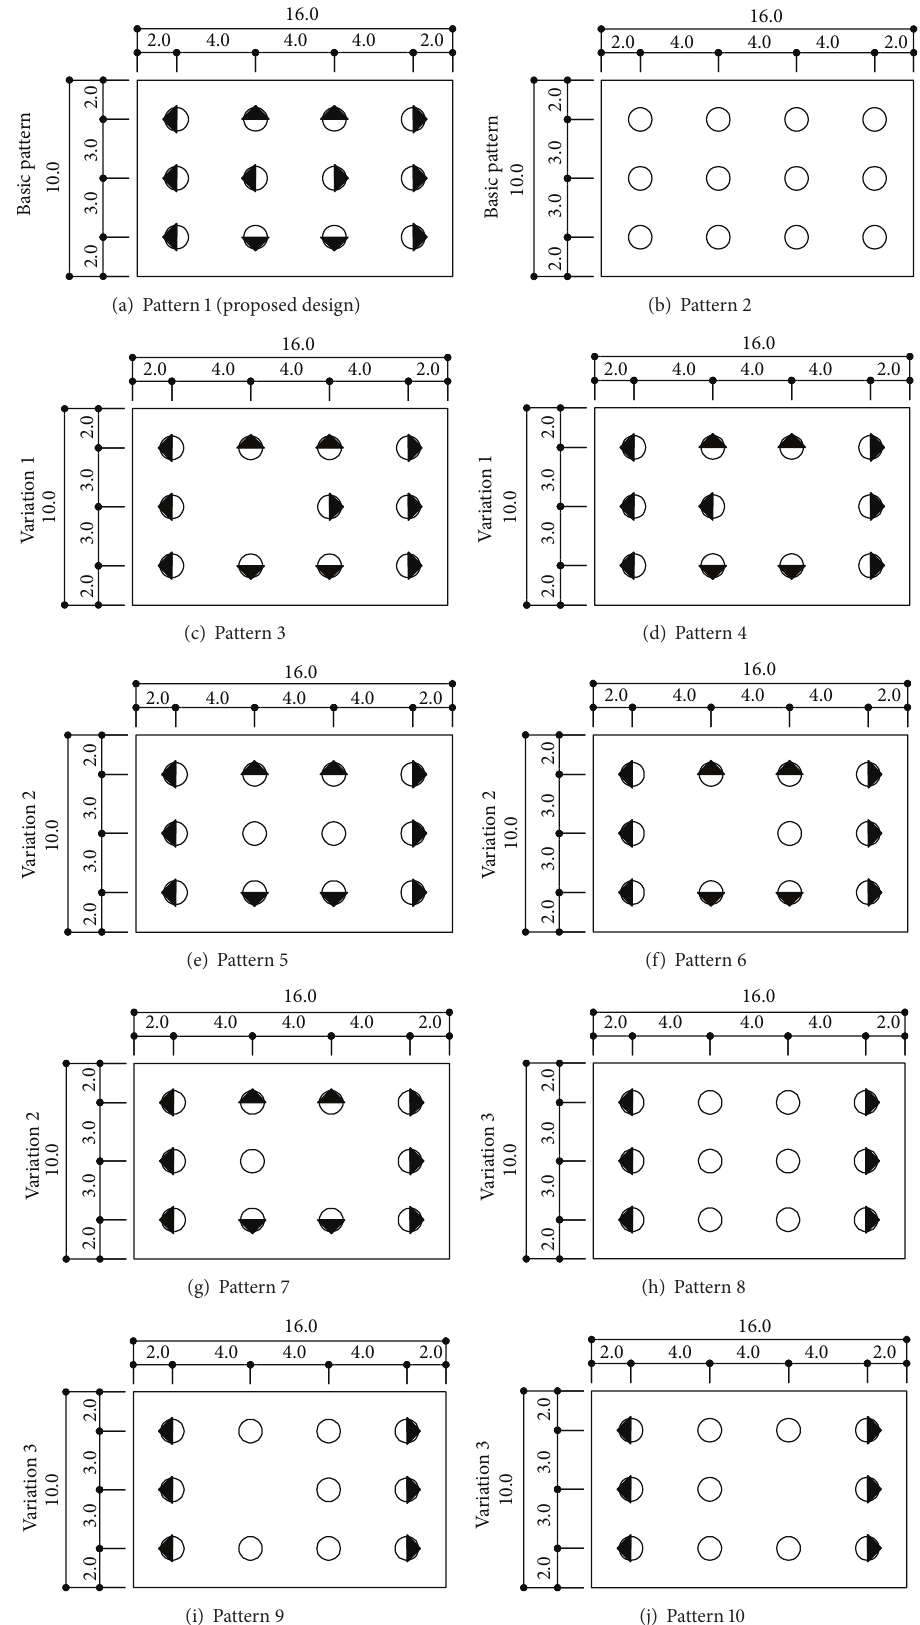
Figure 4: Patterns of piles (circle means vertical pile and circle with triangle means battered